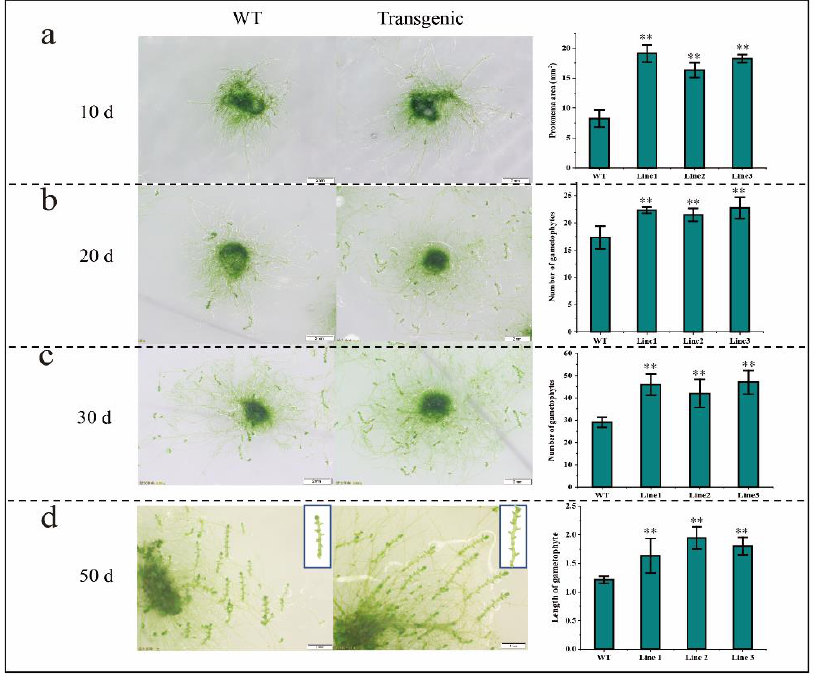
Figure 4. Phenotype of wild-type and BaZFP1 -overexpressing lines of phenotype and data statistics in B. argenteum . ( a ) The phenotype of B. argenteum protonema transferred to KNOP medium for growth for 10 days, protonema area statistics; ( b ) the phenotype growth for 20 days, number of gametophytes statistics; ( c ) the phenotype growth for 30 days, length of gametophyte statistics; ( d ) the phenotype growth for 50 days, length statistics of gametophytes. Three independent biological replicates were performed, and vertical bars refer to ± SD (n = 3). Asterisks indicate significant differences between WT and transgenic lines (* p < 0.05; ** p < 0.01).